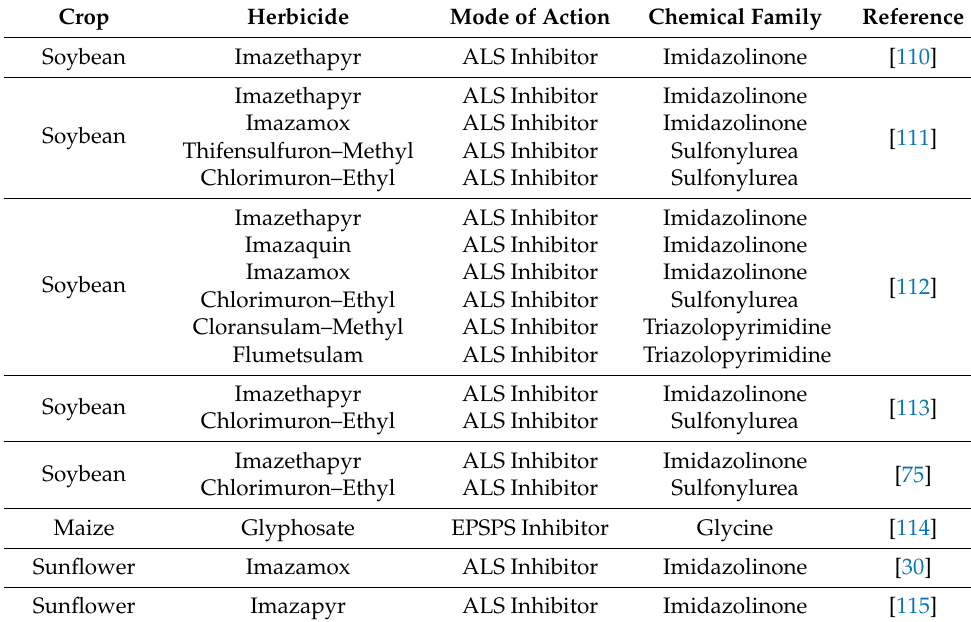
Table 4. Cases of herbicide resistance in weedy sunflower [ Helianthus annuus L.] populations. Results presented are from temporally and spatially replicated dose-response